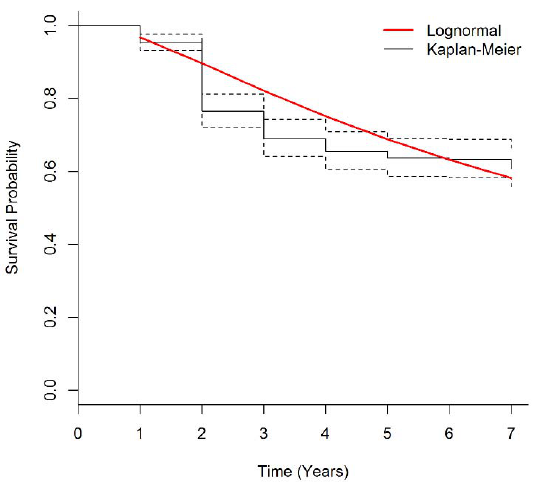
Figure 2. Survival of seedling clusters over seven years. Comparison of the log ‐ normal model fit with the Kaplan ‐ Meier curve. Dashed lines represent 95% confidence intervals. the Kaplan-Meier curve. Dashed lines represent 95% confidence